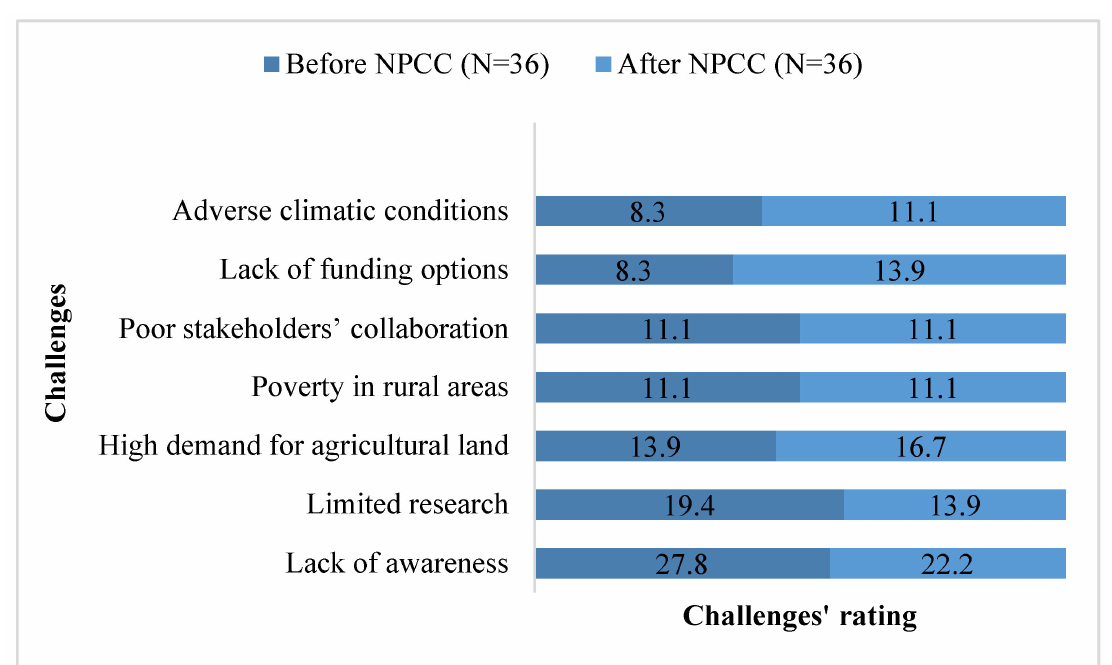
Figure 2. Challenges in the implementation of adaptation actions before and after the NPCC. Chal- lenges’ ratings are presented as